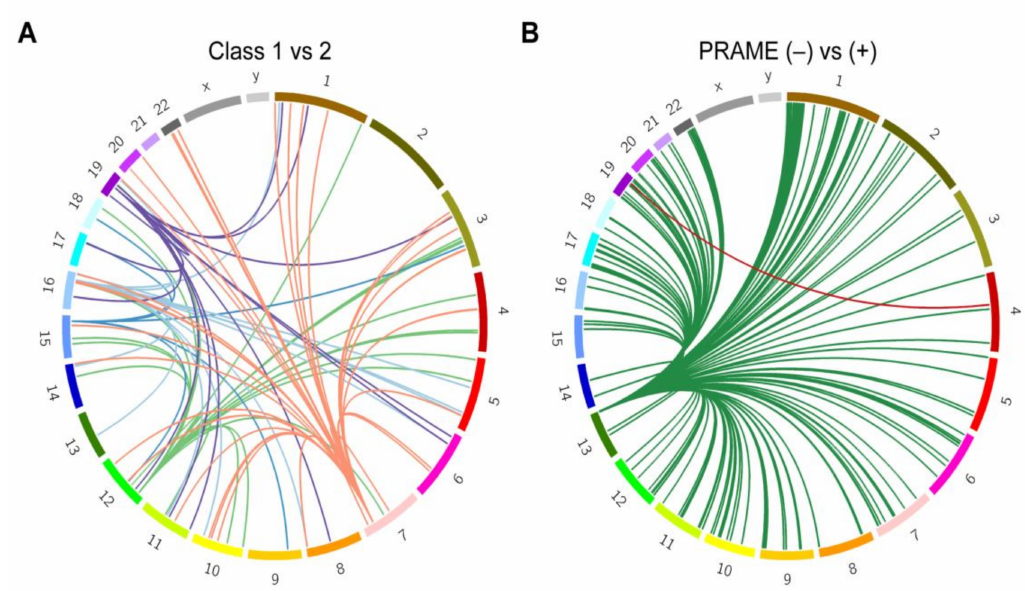
Figure 4. Expression quantitative trait loci (eQTL) analysis. Circos plots showing links between eQTL variants and the cis and trans genes they are a ff ecting. Chromosomes are arranged in a circle as indicated. Lines of the same color are associated with the same set of variants (represented by the root of each group of lines). ( A ) genes a ff ected by the five variant loci associated with GEP assignment (class 1 versus class 2). ( B ) genes a ff ected by the two variant loci associated with PRAME status (negative versus